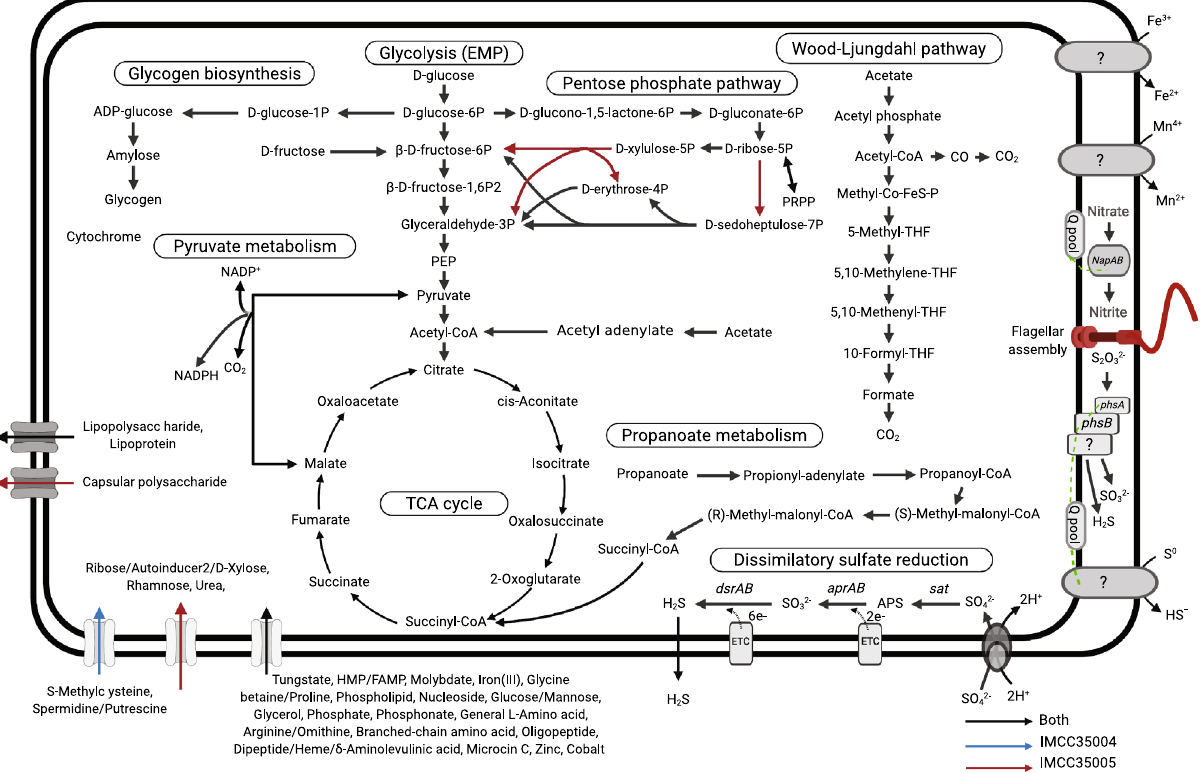
Figure 3. Overview of the metabolic pathways in strains IMCC35004 T and IMCC35005 T . The presence and absence of genes were predicted based on the annotations from Kyoto Encyclopedia of Genes and Genomes. Genes predicted to be present in the phenotypic characterization but not found in the genome sequences are marked with question marks. Created with